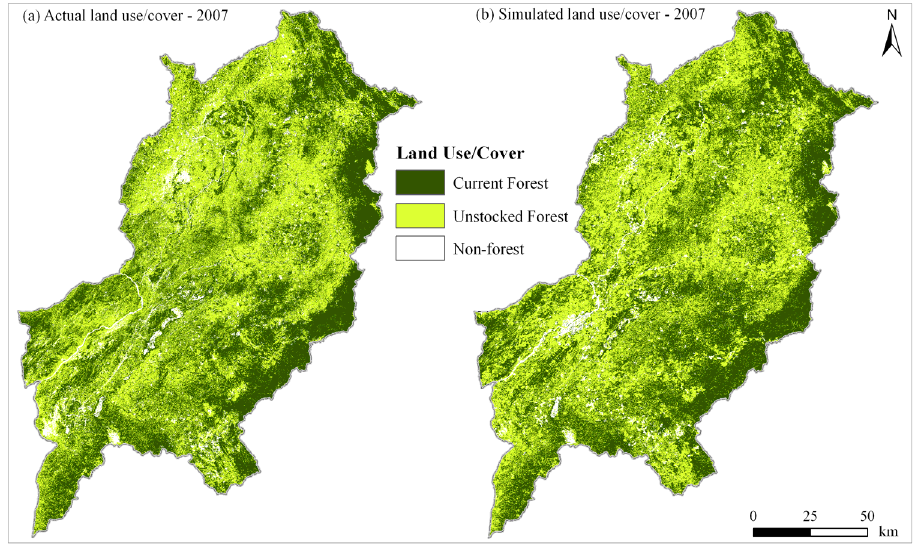
Figure 6. Actual (observed) versus simulated forest cover maps (2007).